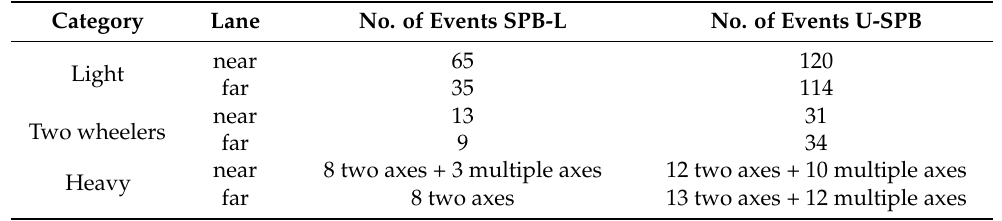
Table 7. Number of analyzed pass-bys in V.